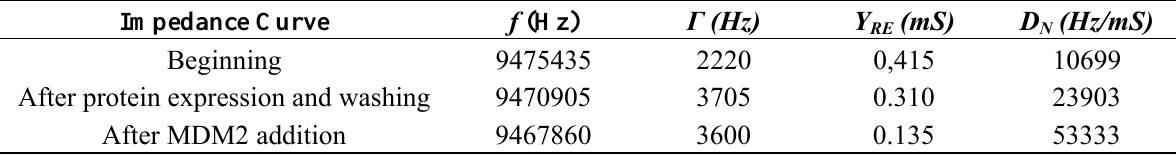
Table 2. Peak frequency ( f ), half-width at half-height ( Γ ), maximum conductance increment ( Y ), and normalized D factor for the impedance curves shown in Figure 7 Left. RE Impedance